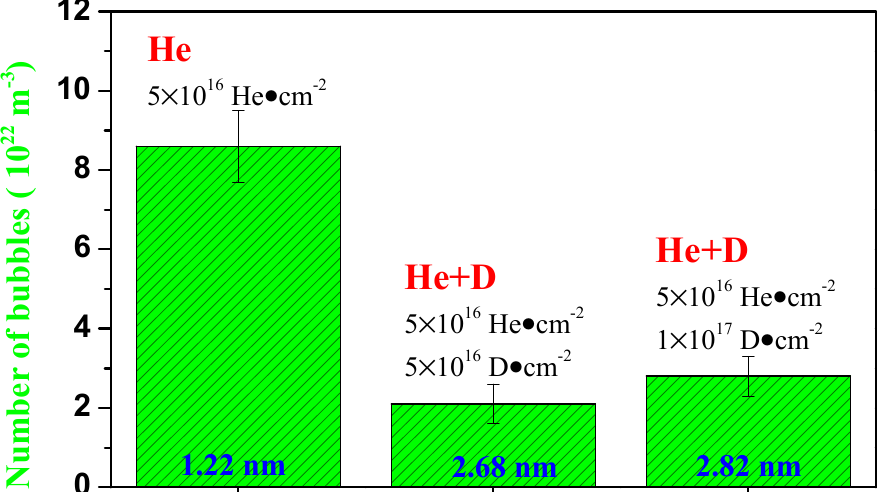
Figure 7. The density and average size of the bubbles in the TEM images of the irradiated samples.